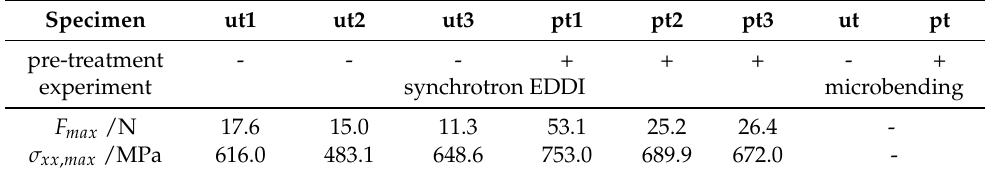
Figure 9. SEM secondary electron images of the struts after failure and cross sections near the fracture zone analyzed by optical microscopy after polishing: the decohesion in case of the untreated specimen ( grey ) is clearly visible whereas the pre-treated specimen ( red ) shows a fracture of the Ni coating but no visible decohesion in the cross section. Table 2. Summary of the analyzed specimens of the untreated (ut) and pre-treated (pt) foam, the maximum force F max and the maximum mean in-plane bending stress σ xx , max